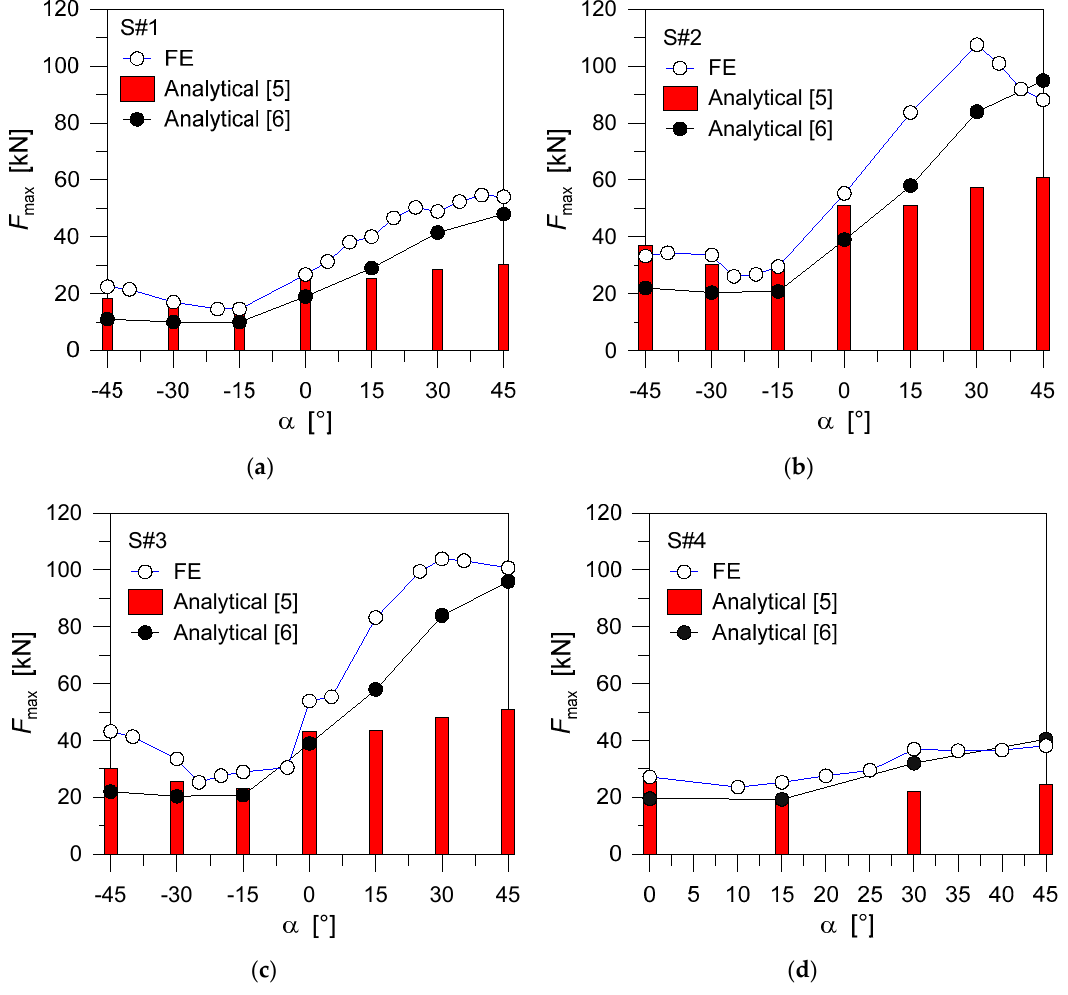
Figure 12. Comparison of numerical (ABAQUS/Explicit) and analytical (Eurocode 5 [5] or Tomasi et al. [6]) maximum force estimates for TTC joints with inclined STSs: ( a ) S#1, ( b ) S#2, ( c ) S#3 and ( d ) S#4 joints.